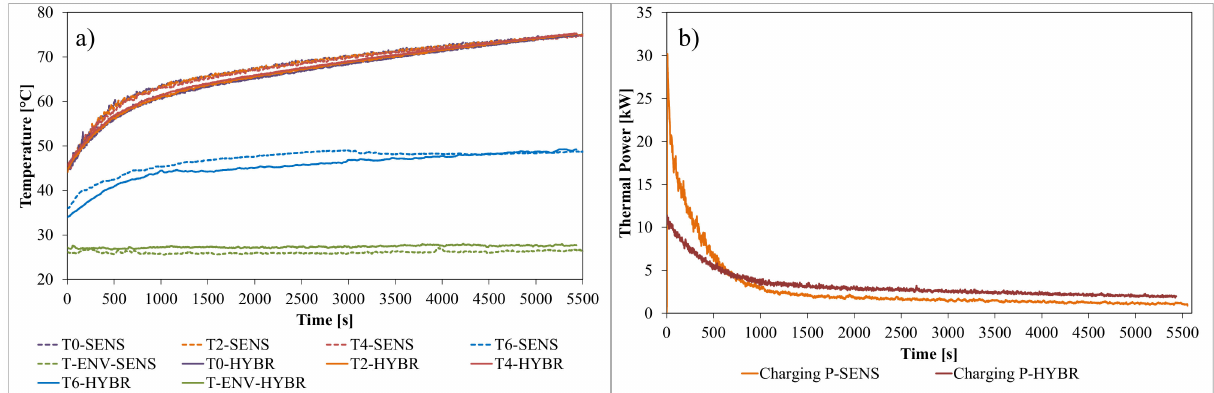
Figure 6. Comparison between charging phases at 10 kg/min for both tested configurations in the temperature range 45–75 ◦ C. Dynamic evolution of three reference internal temperatures along the height of the tank, the temperature of the insulation and the ambient temperature ( a ). Comparison between charging power measured ( b